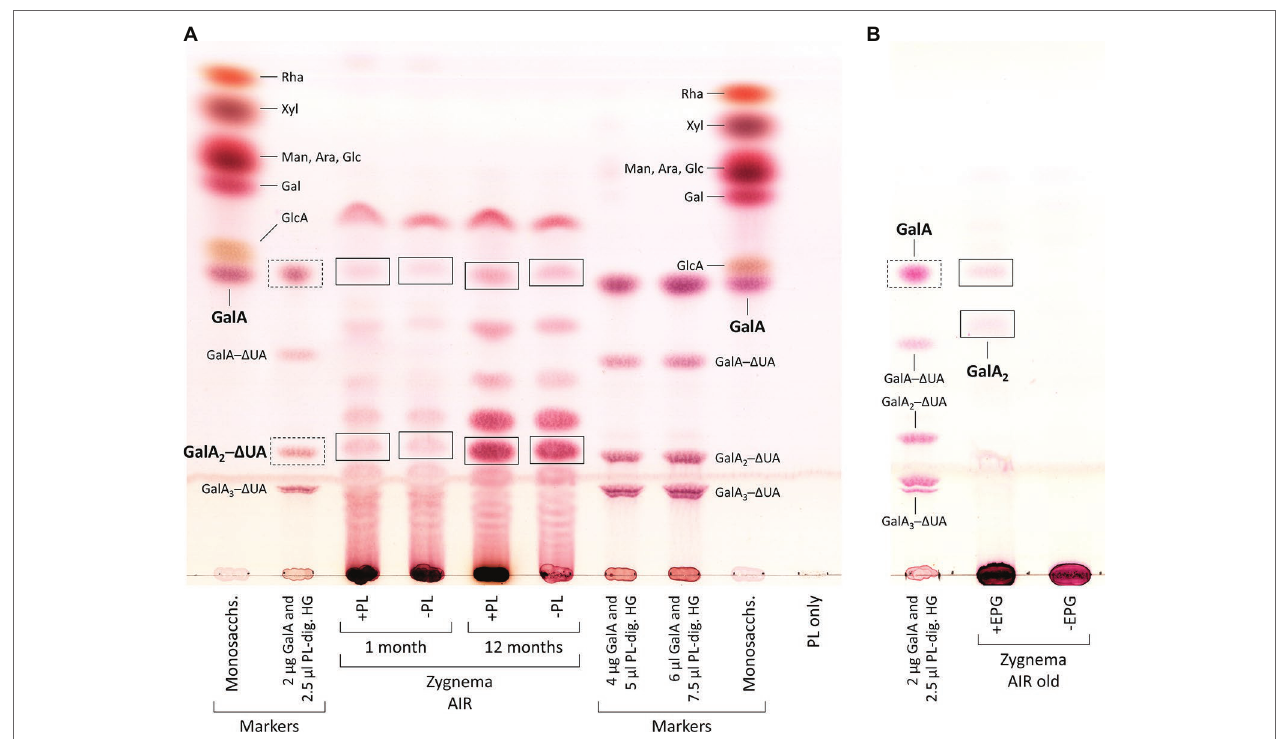
FIGURE 6 | Enzymatic release of HG-derived oligosaccharides from cell walls of young and old Zygnema filaments. (A) AIR samples were either treated with PL (+PL) or buffer only (−PL, controls) and digestion products separated by thin-layer chromatography (TLC). (B) Old Zygnema AIR treated with EPG (+EPG) or buffer (−EPG) and product separation by TLC. Monosaccharide and galacturonic acid oligosaccharides (GalA (1–3) –ΔUA, as concentration gradient) markers are shown in separate tracks. Expected HG oligosaccharide and GalA bands in Zygnema AIR (rectangles) and GalA 1–3 –ΔUA marker bands (rectangles with dashed